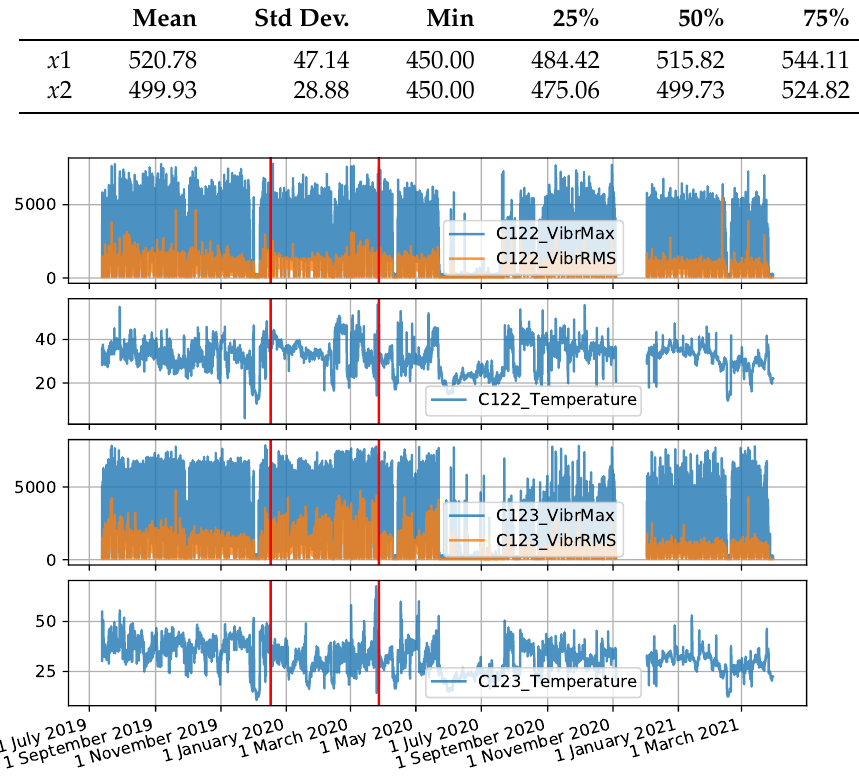
Figure A2. Time series for the NW-10 crusher collected by two sensors (the red colour indicates the locations of failures).